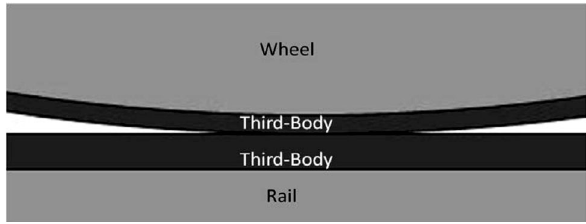
Fig. 15 Lubricating rails to reduce surface friction